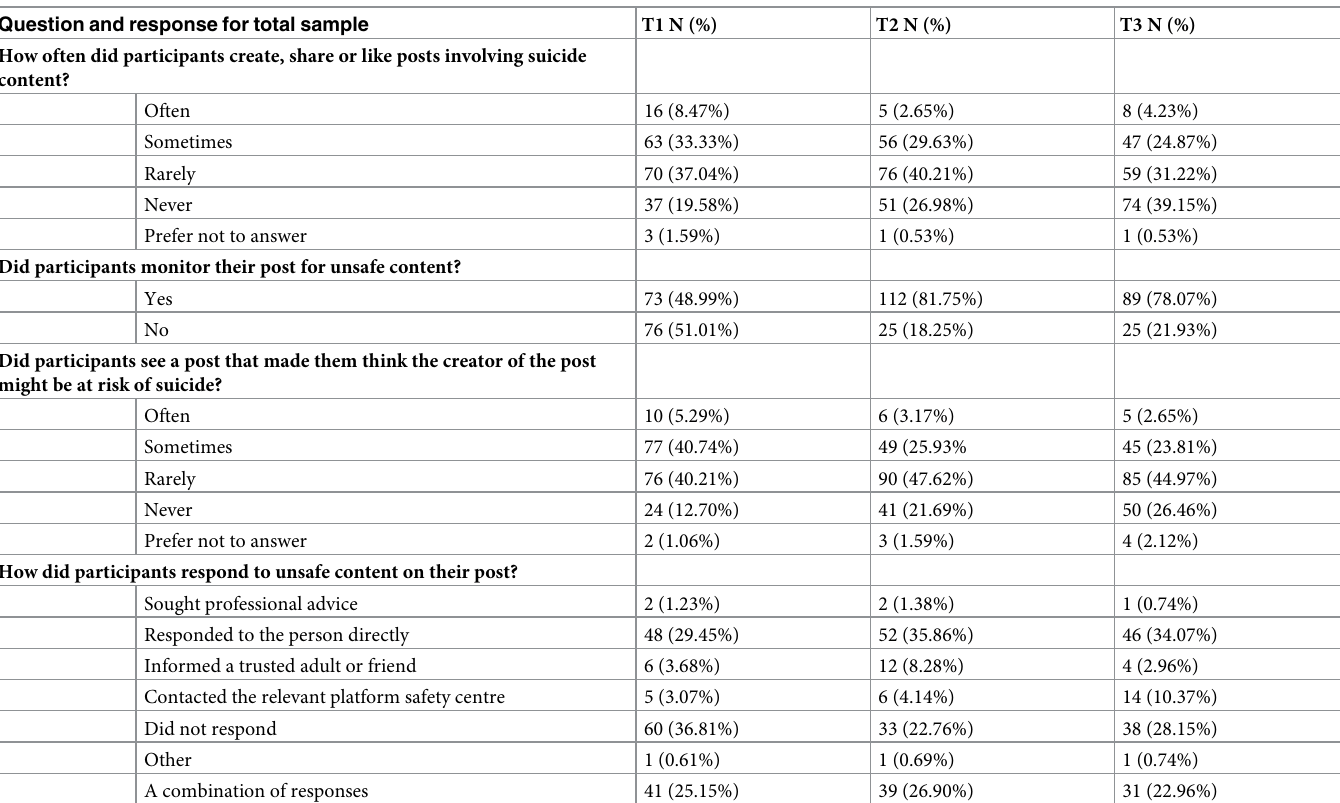
Table 7. Select questions and responses from the Perceived Safety questionnaire across